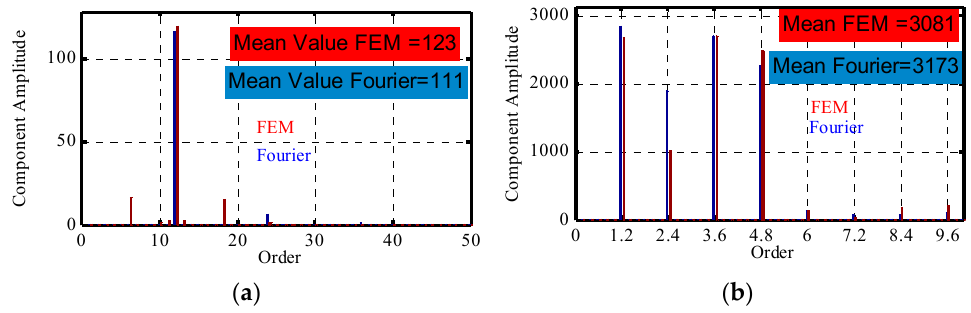
Figure 13. Magnetic pressure distribution created by stator coils on the rotor surface of the Qs36p15 machine: ( a ) temporal, ( b ) spatial.